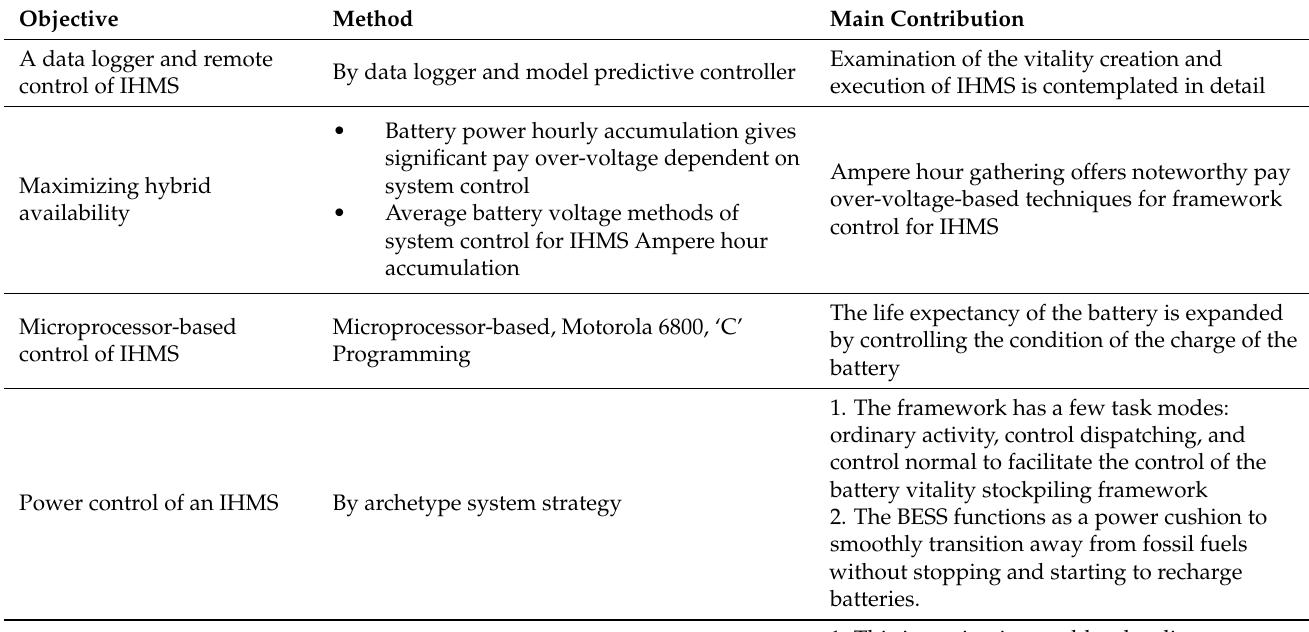
Table 6. Summary of the IHMS solar wind control technique [145].